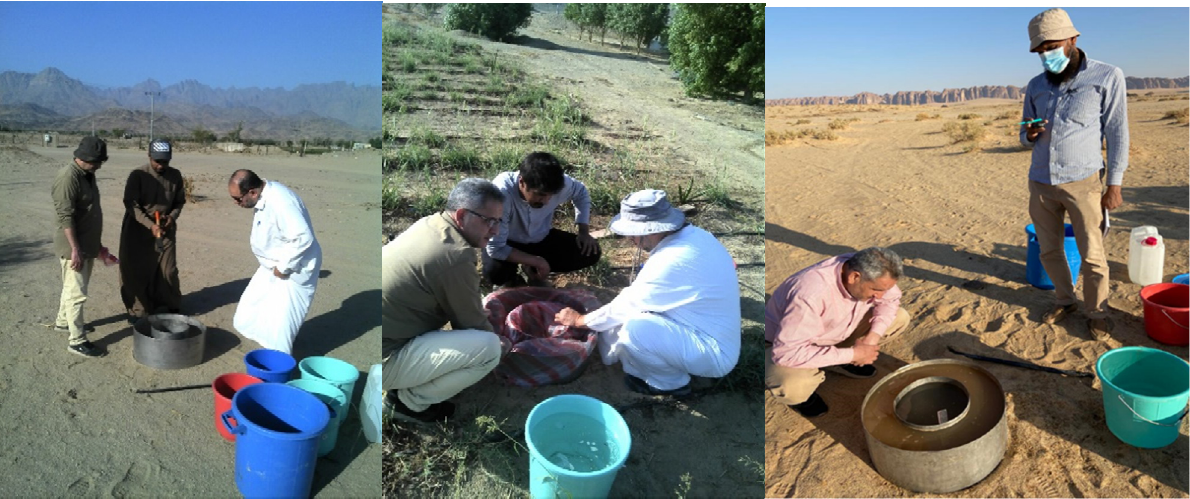
Figure 7. Photos during performed infiltration tests in the field using a double ‐ ring infiltrometer.